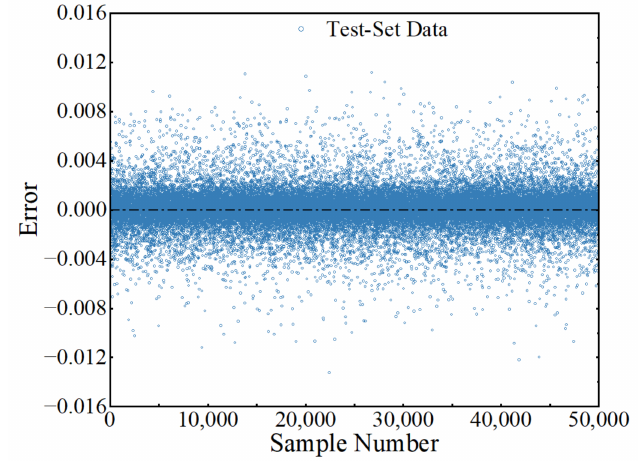
Figure 15. Errors in predicting the test-set samples.